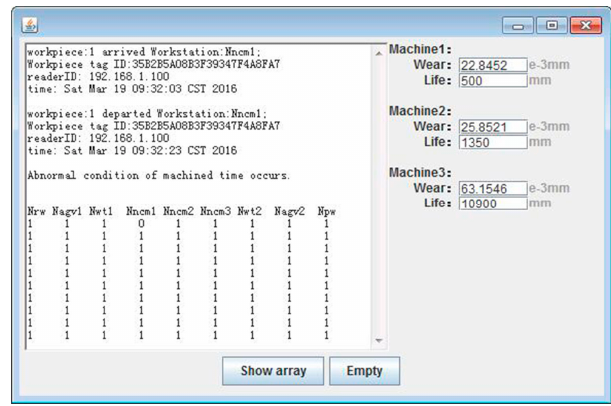
Figure 13. The user interface of tool wear and RUL.